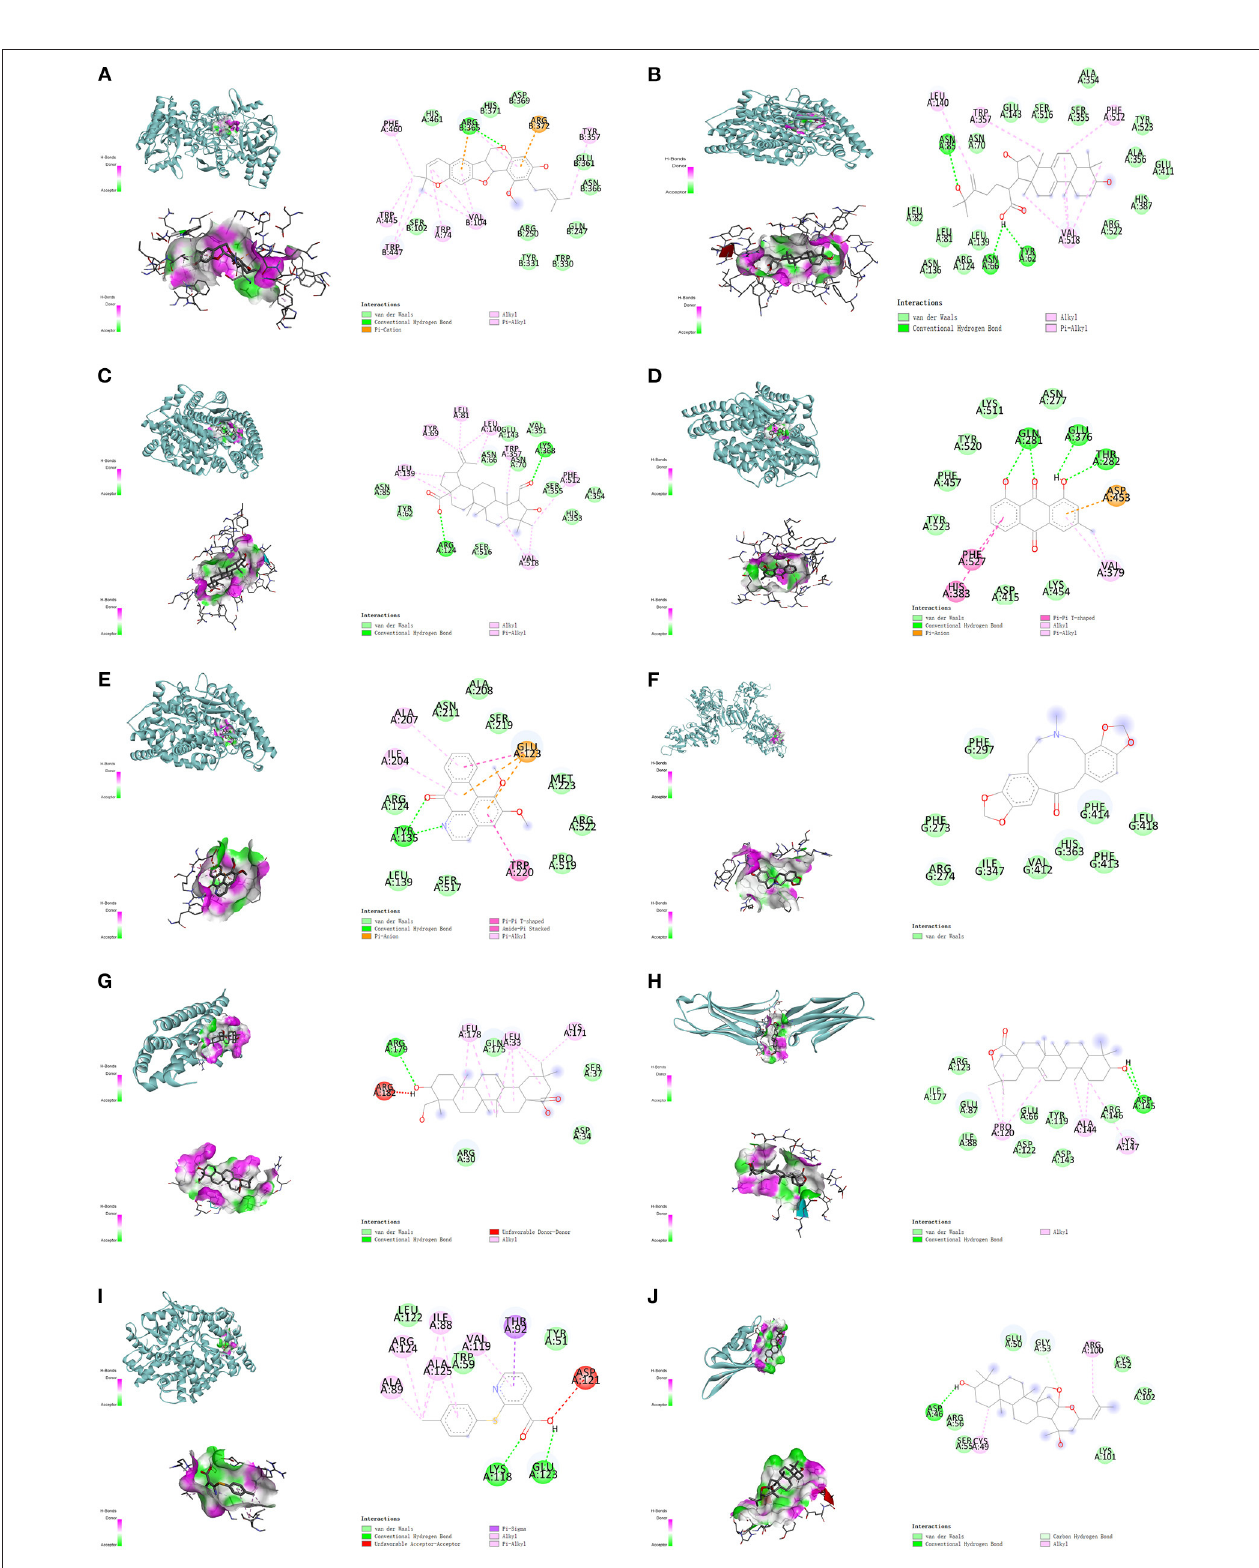
FIGURE 7 | The top 10 binding energy molecular docking models. (A) Kanzonol F and NOS3. (B) 25-Hydroxy-3-epidehydrotumulosic acid and ACE. (C) Colubrinic acid and ACE. (D) Chrysophanol and ACE. (E) Lysicamine and ACE. (F) Fumarine and SIRT1. (G) Hederagenin and IL-6. (H) Machaerinic acid lactone and VCAM-1. (I) JL1 and ACE. (J) Jujubogenin and